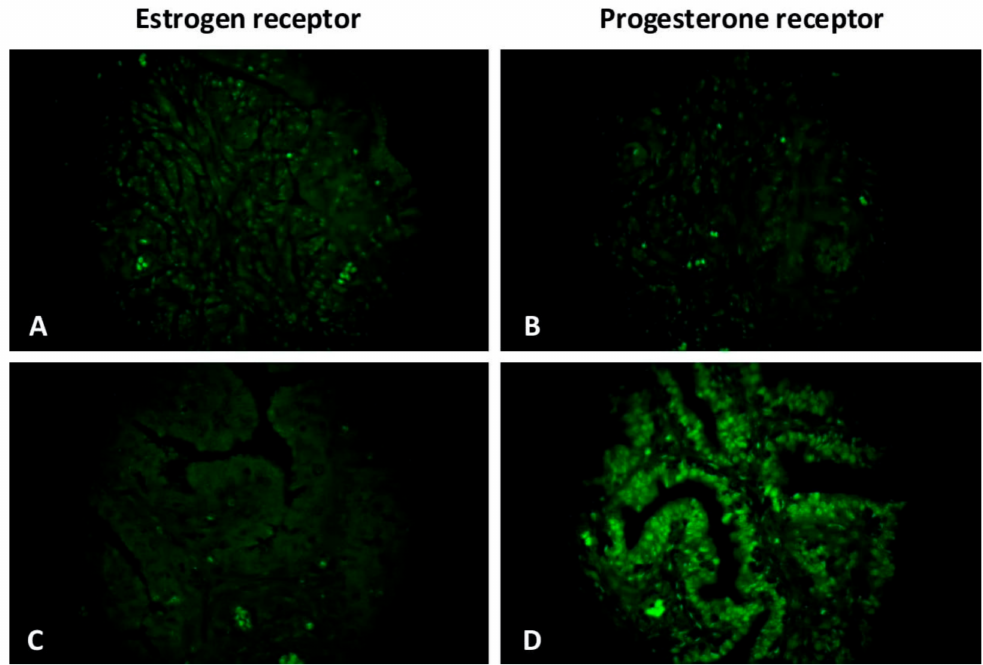
Figure 7. The oviduct tissue (ampulla section) from patients with uterine myoma ( C , D ) and without ( A , B ) stained for estrogen ( A , C ) and progesterone ( B , D ) receptors (green, Alexa Fluor 488). Nuclear receptors for both steroid hormones were expressed in the mucosal folds of the oviduct. Total magnification: ×